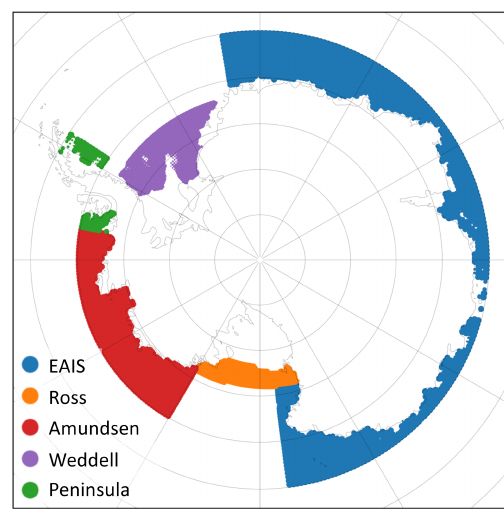
Figure 2. Ocean sector